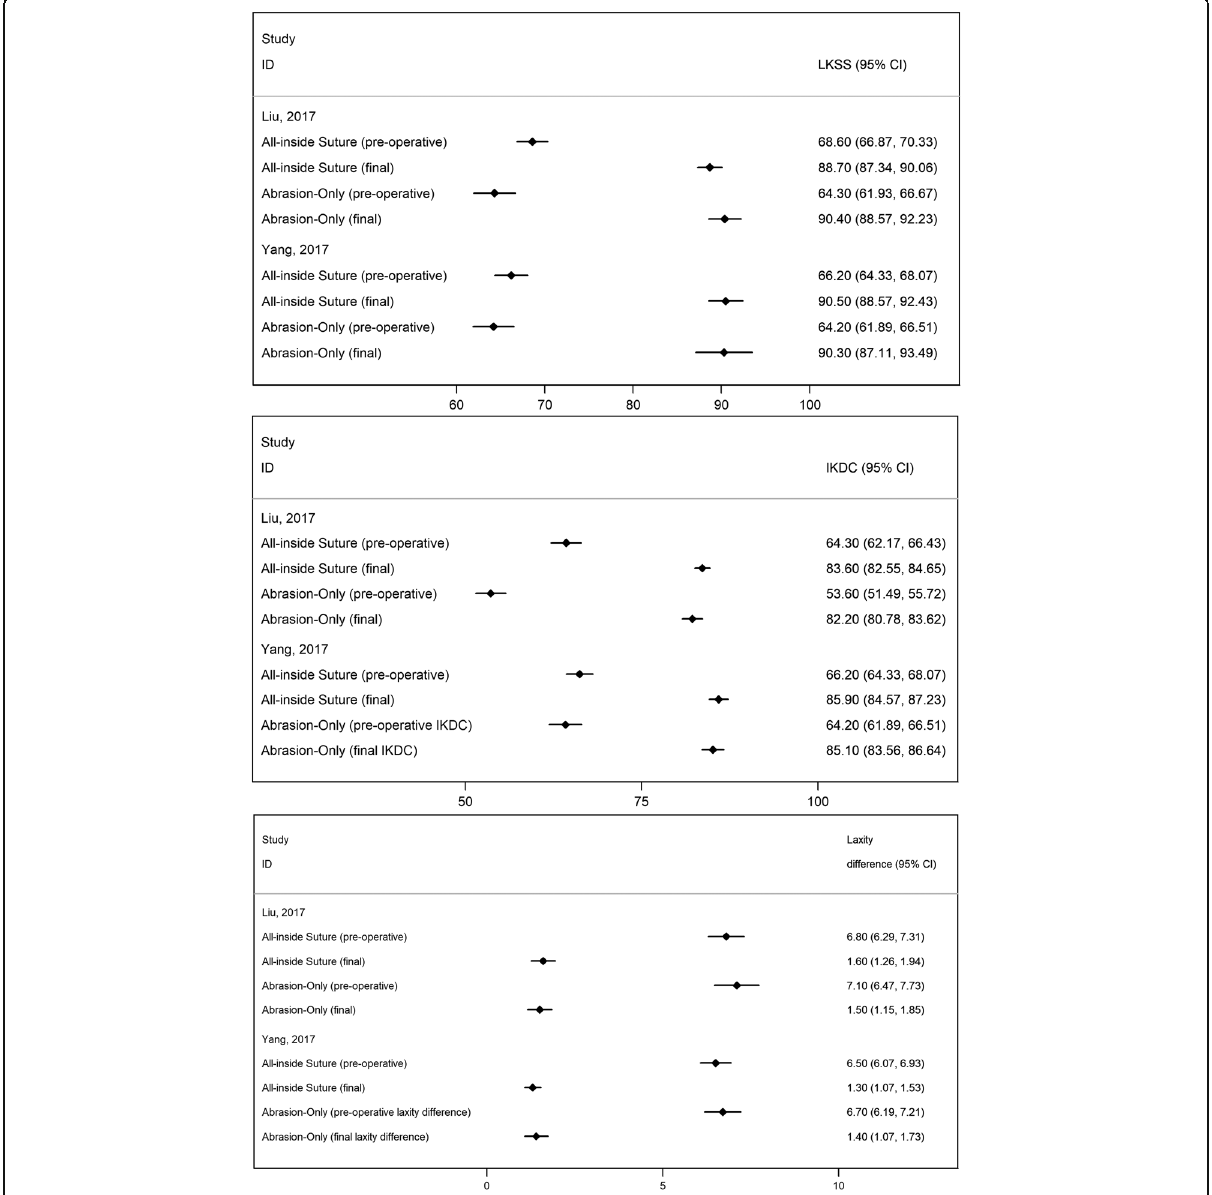
Fig. 5 Forest plots comparing the mean Preoperative and Final (at final follow-up) outcomes between all-inside suture of the medial meniscus versus abrasion and trephination for the repair of small and stable Ramp Lesions (< 1.5 cm), in the two studies that evaluated both techniques. Dots in squares represent the estimated measures while the horizontal lines represent the 95%